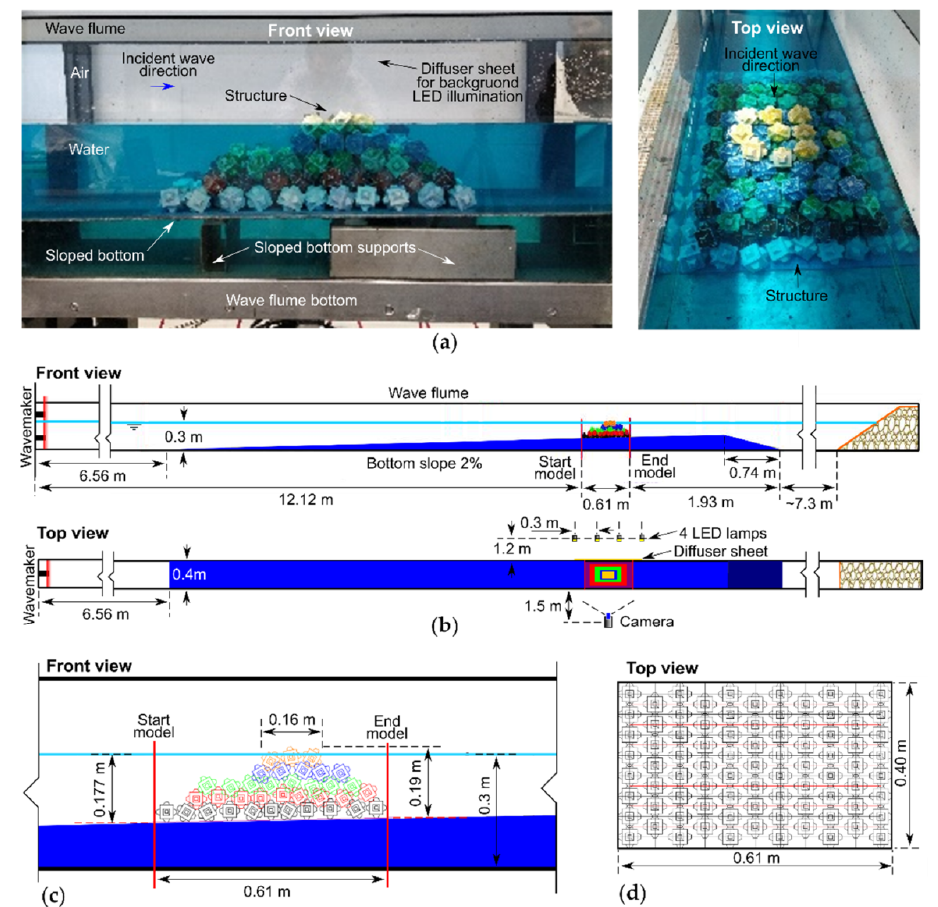
Figure 1. Experimental setup: ( a ) front and top photo views of the Cubipod homogeneous low-crested structure (HLCS); ( b ) sketches of front and top views of the wave flume and the structure location, including dimensions; ( c ) details of the geometric characteristics of the front view of the Cubipod structure; ( d ) top view of the designed placement grid for the bottom layer of the Cubipod armors.